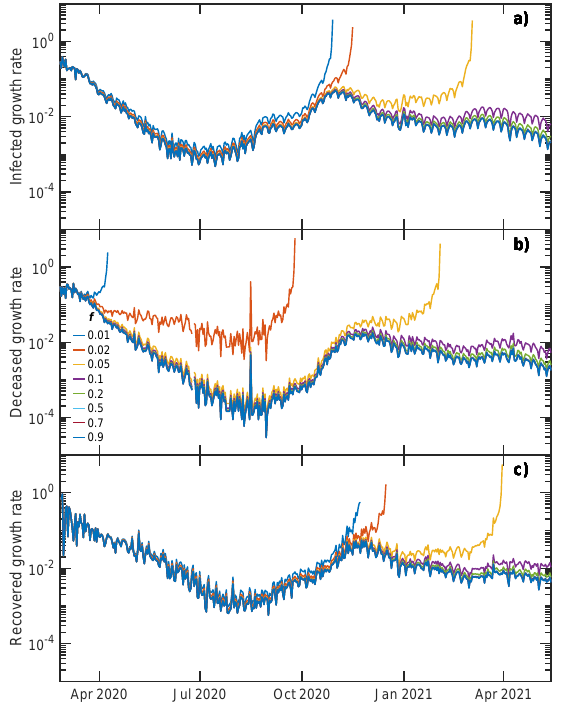
Figure 1. ( a ) Infected, ( b ) deceased and ( c ) recovered growth rate (see Equation (5) for definition) r ( t ) vs. t (days) in a log-lin plot for different values of herd immunity ratio: f = 0.01, 0.02, 0.05, 0.1, 0.2, 0.5, 0.7, 0.9. While r ( t ) shows a clear divergence for f < 0.1, it does not change significantly for f >